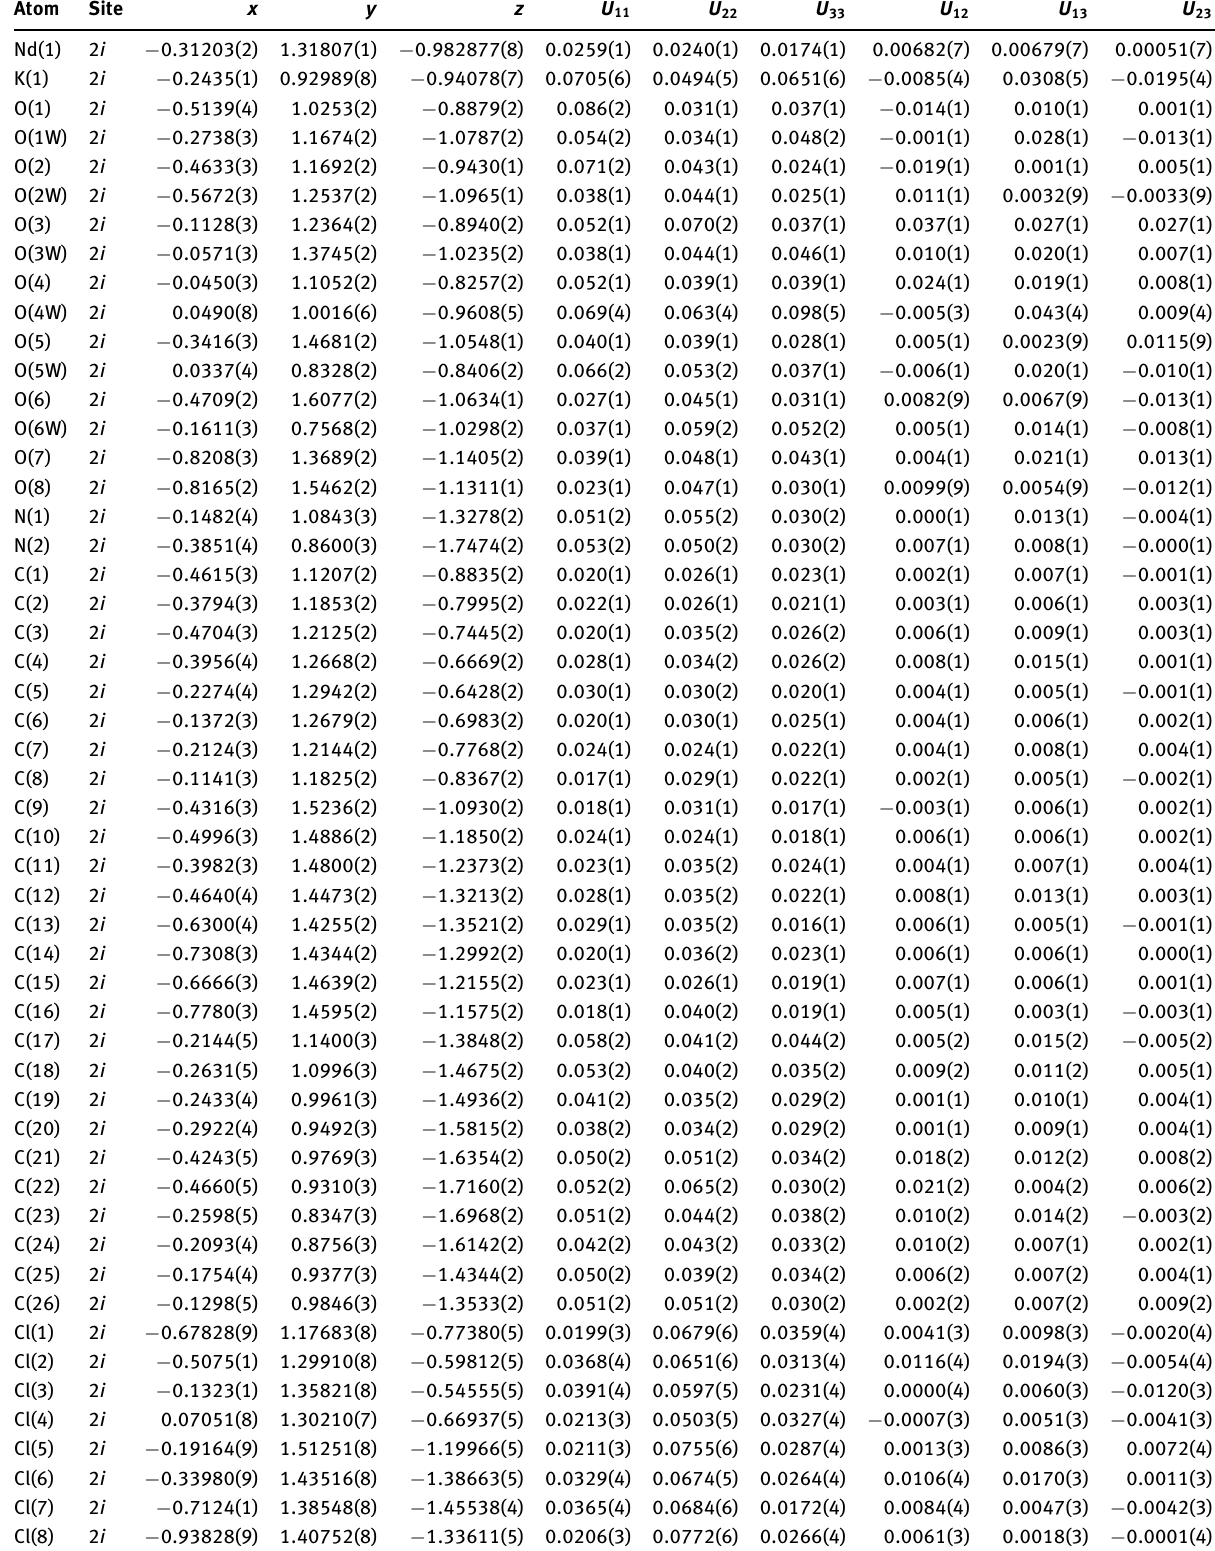
Table 3: Atomic displacement parameters (Å 2